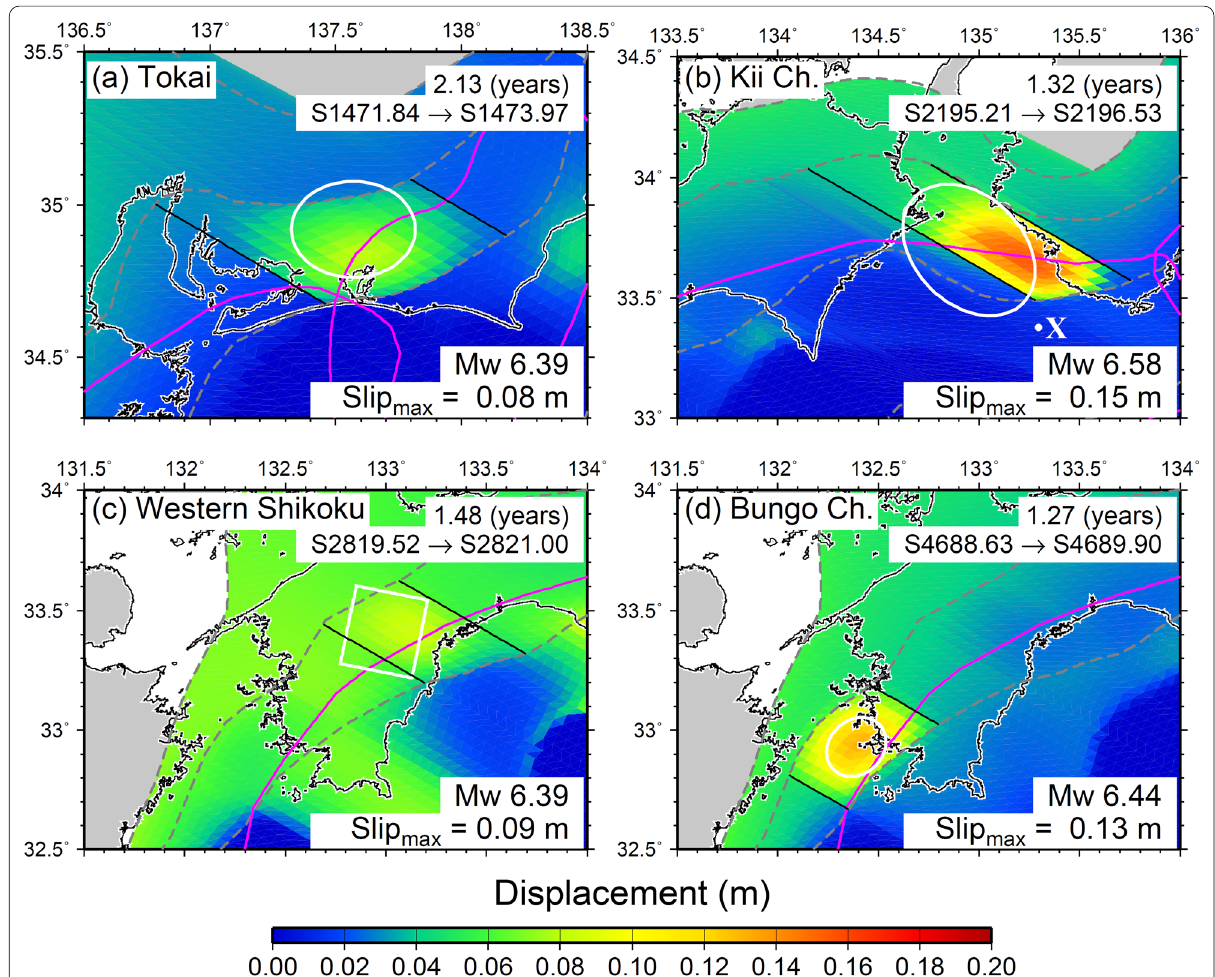
Fig. 13 Distribution of slip on the plate interface during LSSEs. Black lines denote the edges of the source area. LSSEs in a – c and d correspond to LSSEs indicated by circles in a – c and d in Fig. 12, respectively. Other symbols are as shown in Fig.